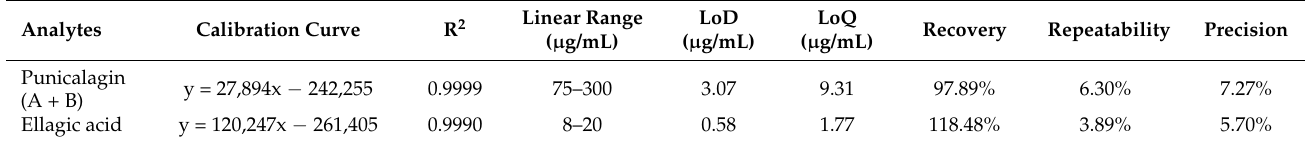
Table 4. Validation parameters of the UHPLC-DAD method for the identification and